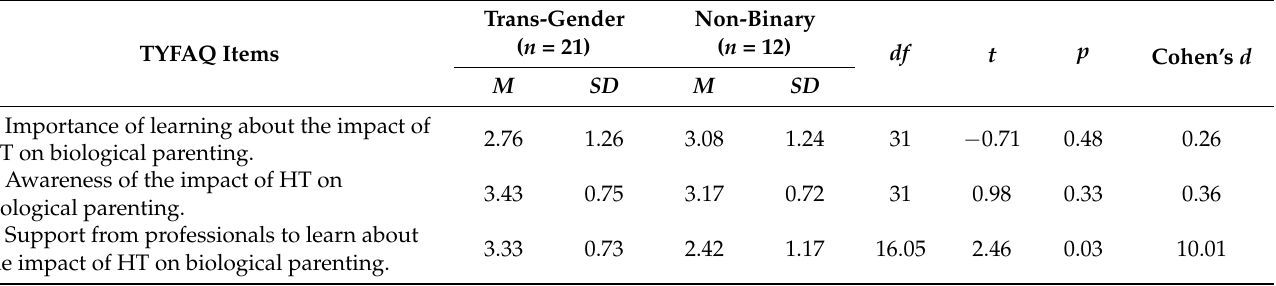
Table 5. Differences in Attitudes Towards Parenthood and Fertility Preservation between Transgender and Non-Binary